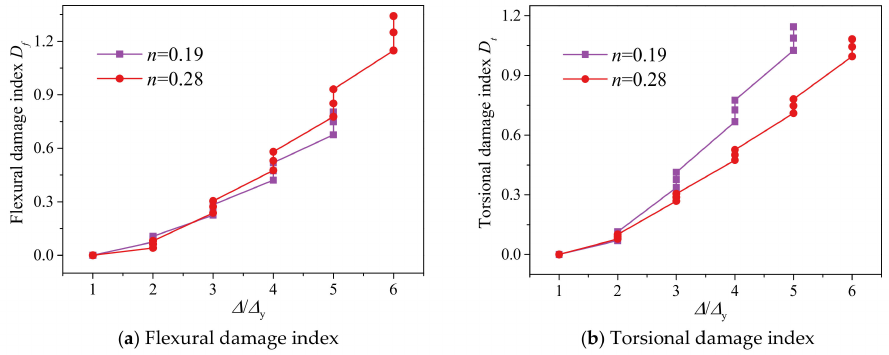
Figure 18. Influence of axial compression ratio on the damage